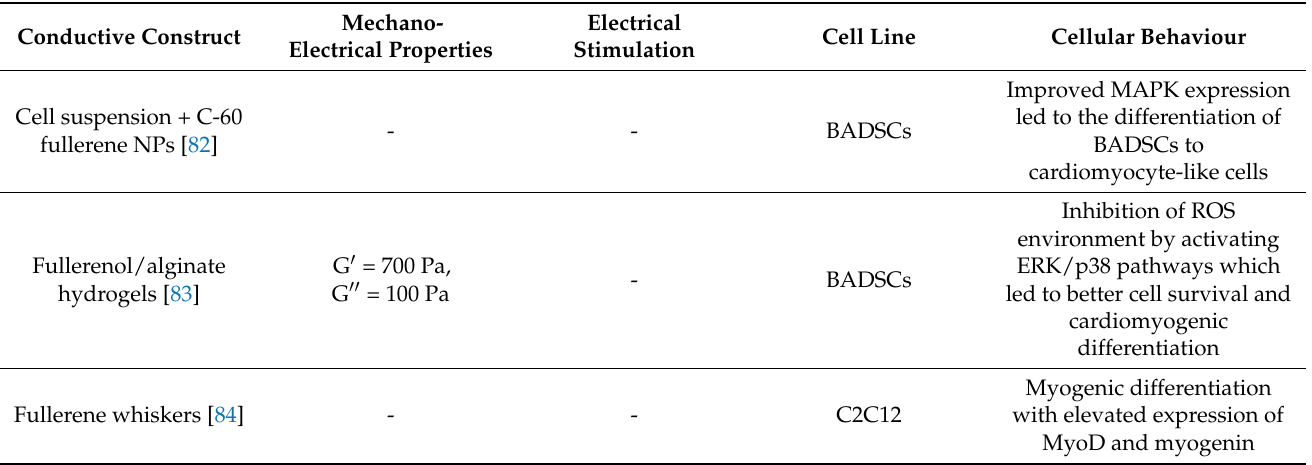
Table 3. Fullerene-based conductive constructs for cardiac tissue engineering